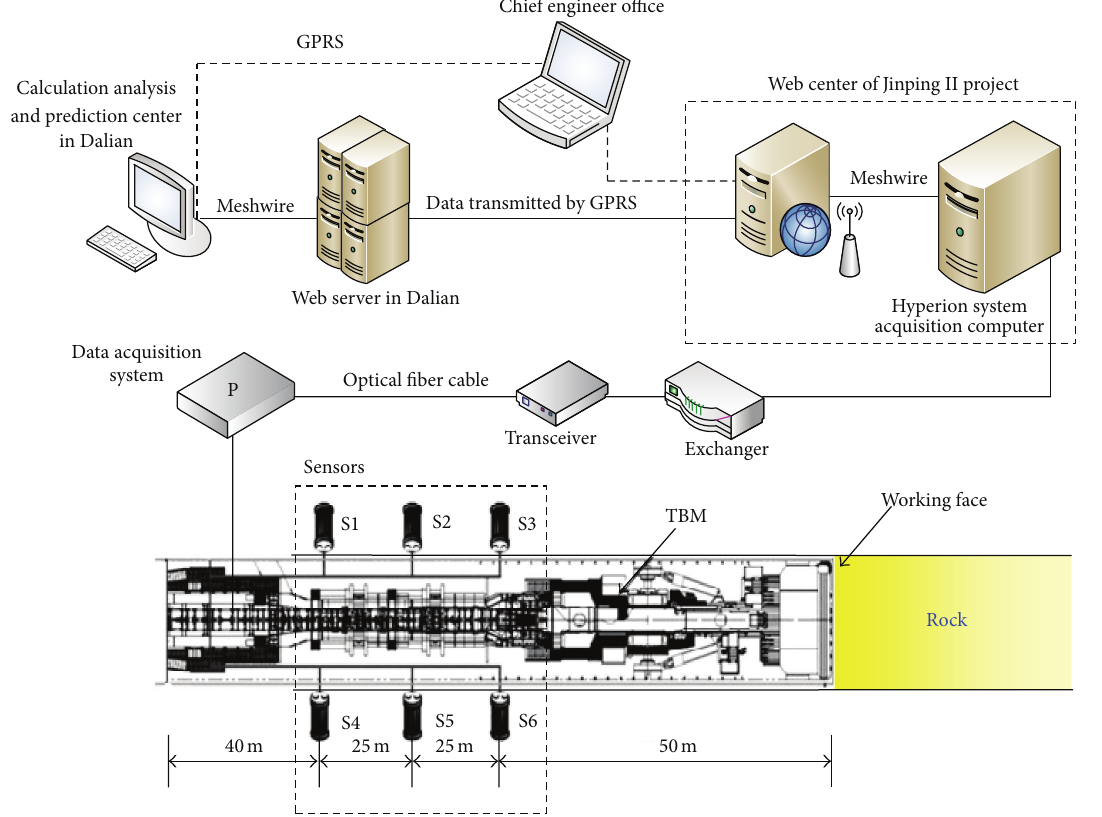
Figure 5: The monitoring and analysis system for rockbursts during TBM tunneling for Jinping II Hydropower Station.